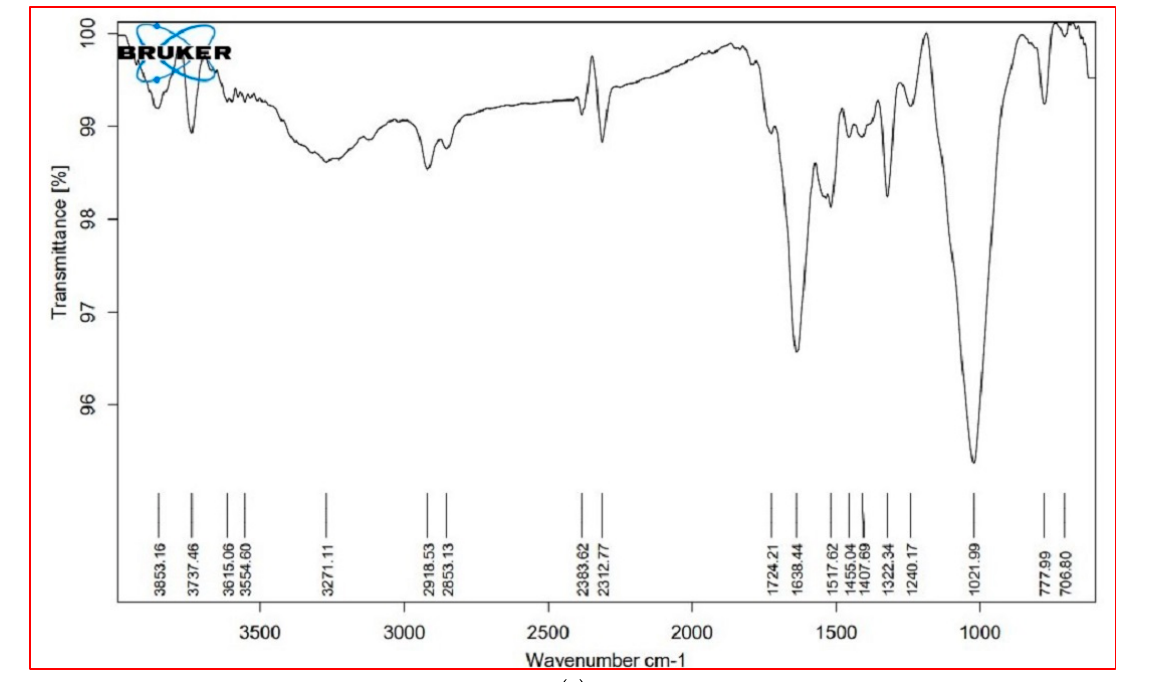
Table 4. Bioaccumulation factor (BAF) values for metals in leaves and stem of plants species.